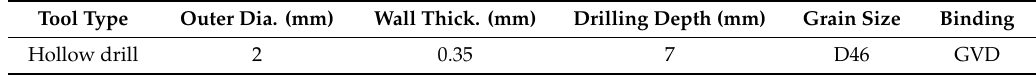
Table 2. Rotary ultrasonic drilling (RUD) tool specifications.